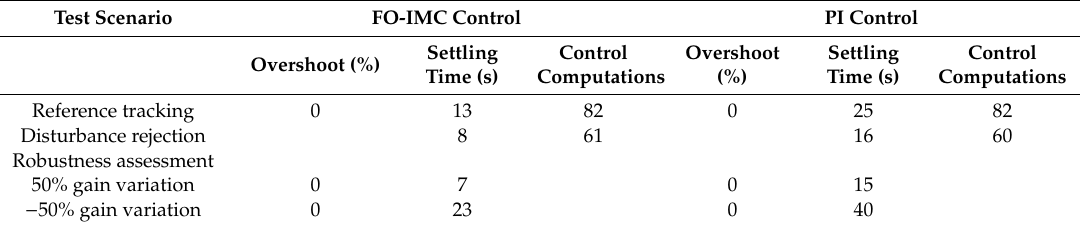
Table 1. Performance comparison between the event-based FO-IMC and event-based PI controller for the lag dominant FOPDT